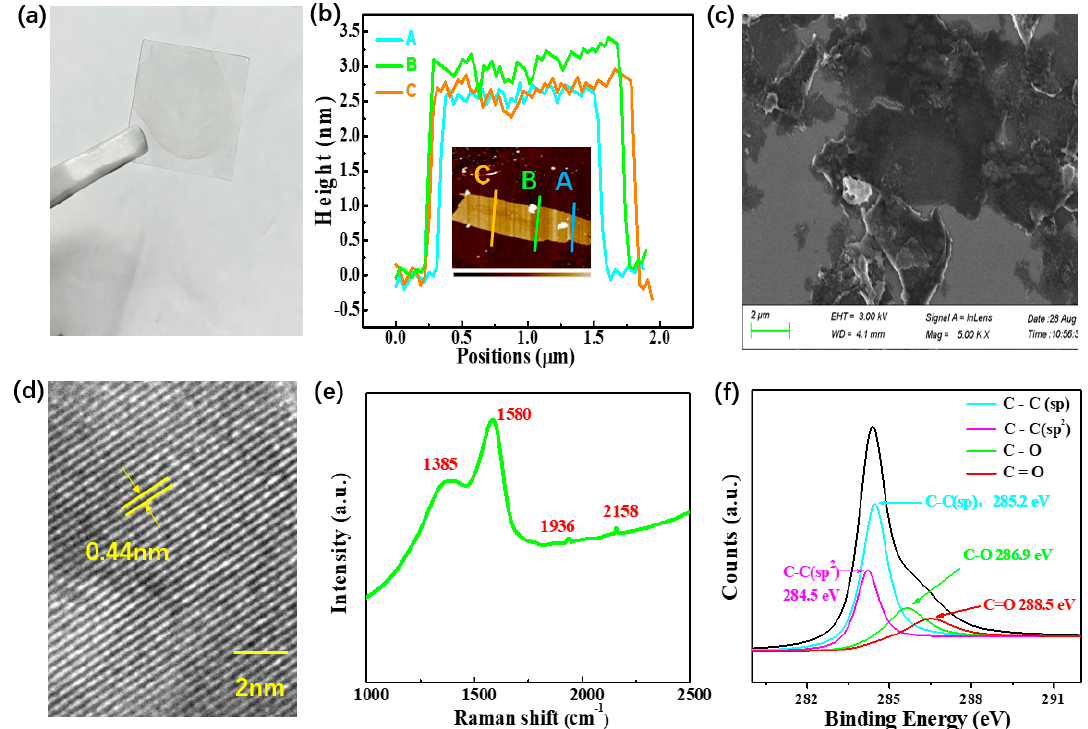
Figure 1. ( a ) Fabricated graphdiyne (GDY) sample on a glass substrate (10 × 10 mm 2 ), ( b ) typical height profiles, inset: Atomic force microscopy (AFM) image, ( c ) SEM image, ( d ) high-resolution transmission electron microscope (HRTEM) image of GDY, ( e ) Raman spectrum of GDY, ( f ) high-resolution XPS spectrum of GDY.